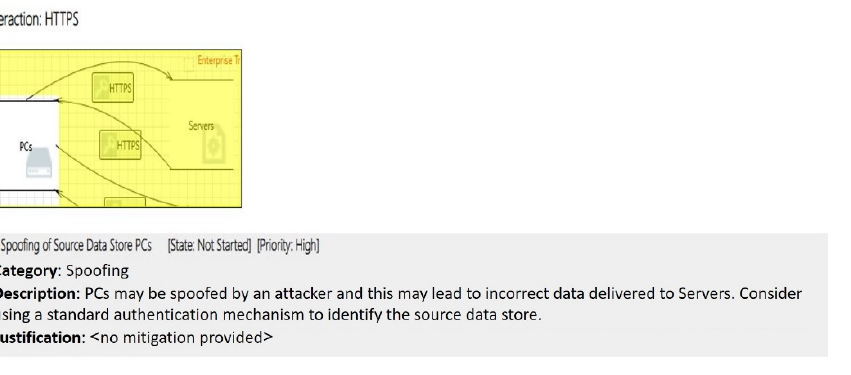
Figure 7. A portion of the MTMT report.